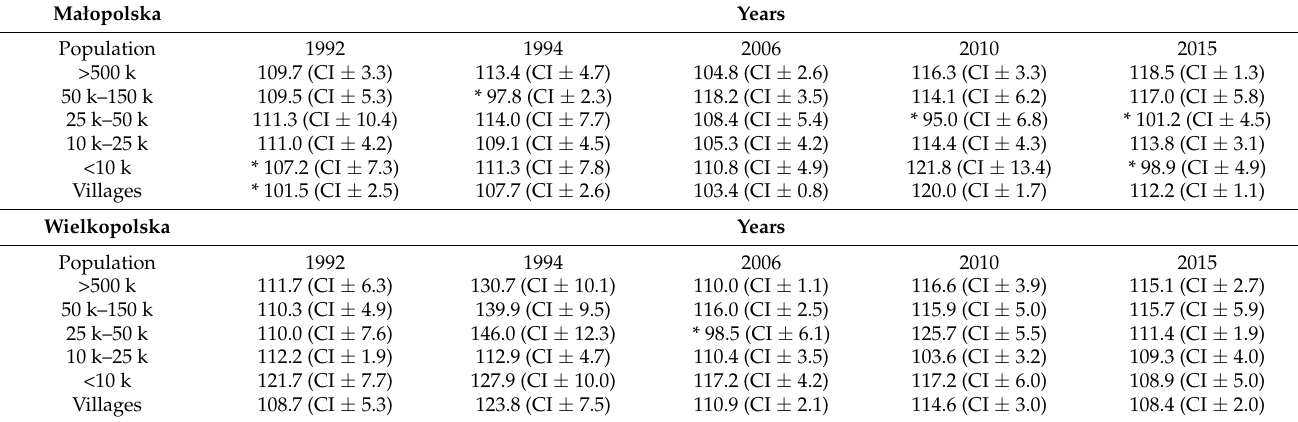
are marked with